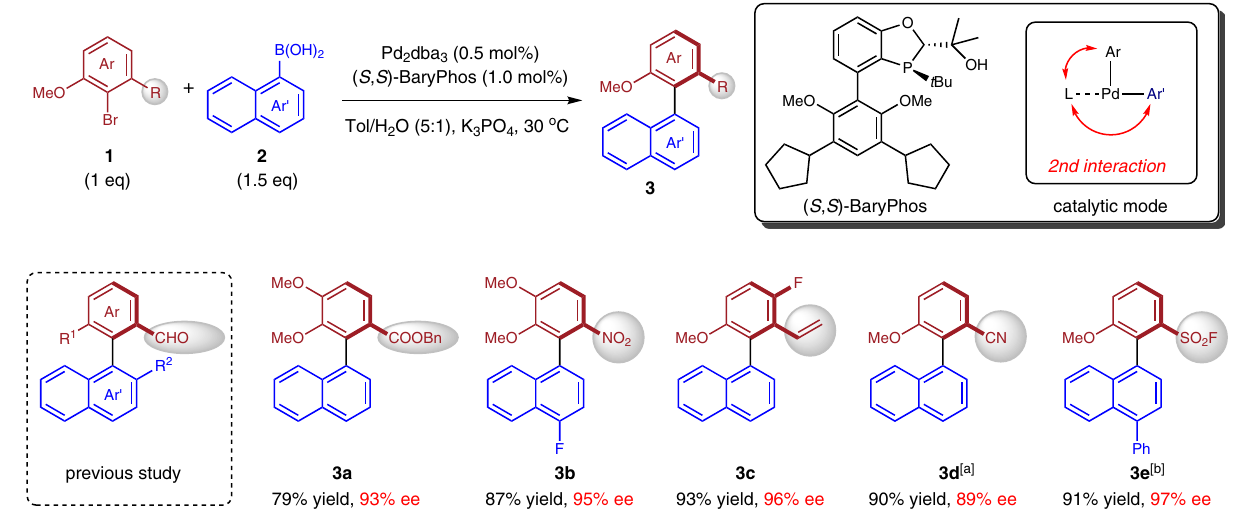
Fig. 2 | The generality of BaryPhos-facilitated enantioselective cross-coupling. Reaction conditions: 1 (0.20mmol), 2 (0.30mmol), Pd 2 (dba) 3 (0.5mol%), ( S , S )- BaryPhos(1.0mol%),K 3 PO 4 (0.60mmol),Tol/H 2 O(5:1),30°C,15h;theyieldsrefer to isolated yields; the ee value was determined by HPLC. a Thermal racemization